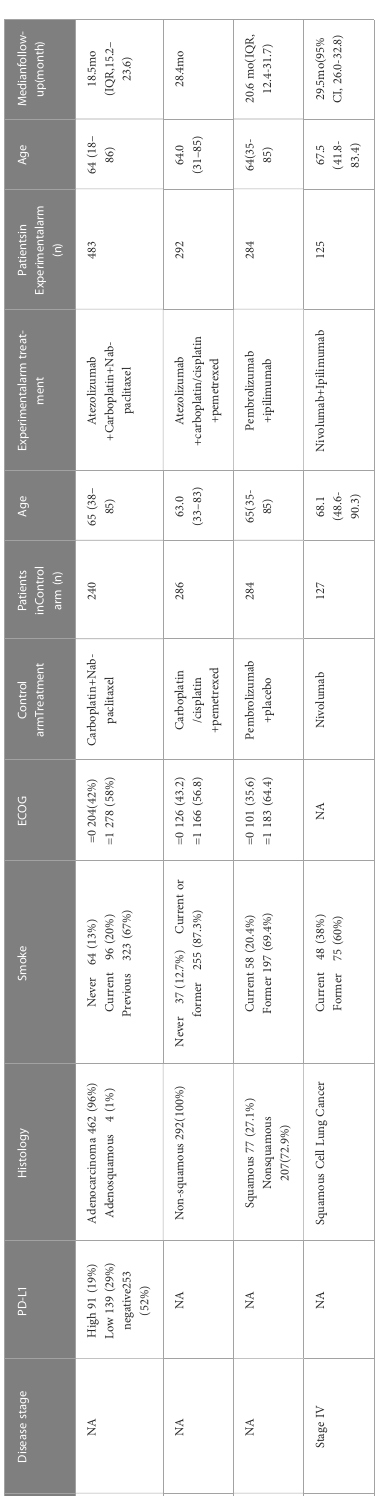
reached stability, which indicated that the model converged well.